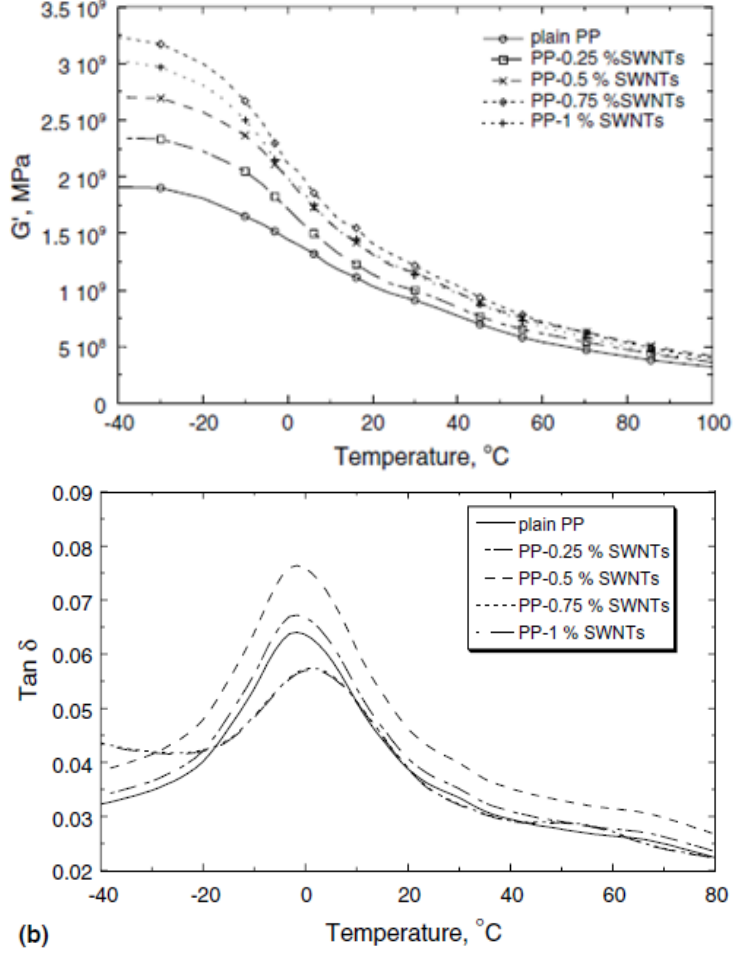
Figure 16. a) Storage modulus for pristine PP and its composites filled with different SWCNTs content and b) Tan δ for pristine PP and its composites as a function of SWCNTs content. Reproduced with permission from ref.